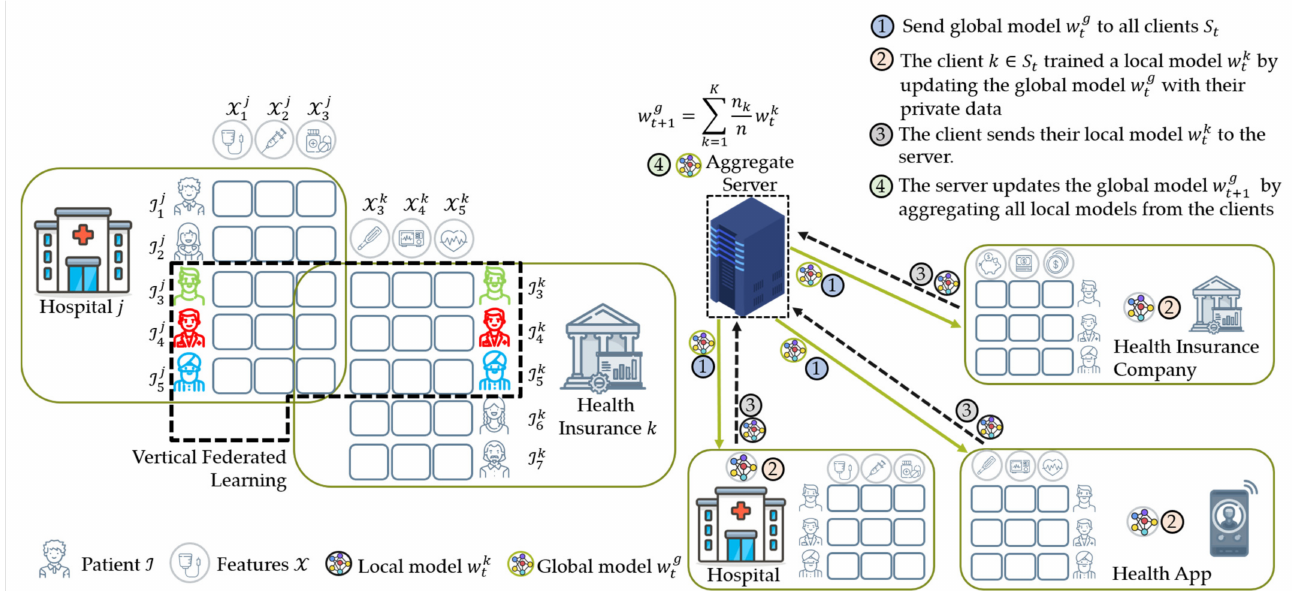
Figure 7. The typical medical data partitions scenario for vertical federated learning (VFL). Each node can be a different medical institution and application. They share the same patients’ index I j = I k but have different features of medical diagnosis X j (cid:54) = X k